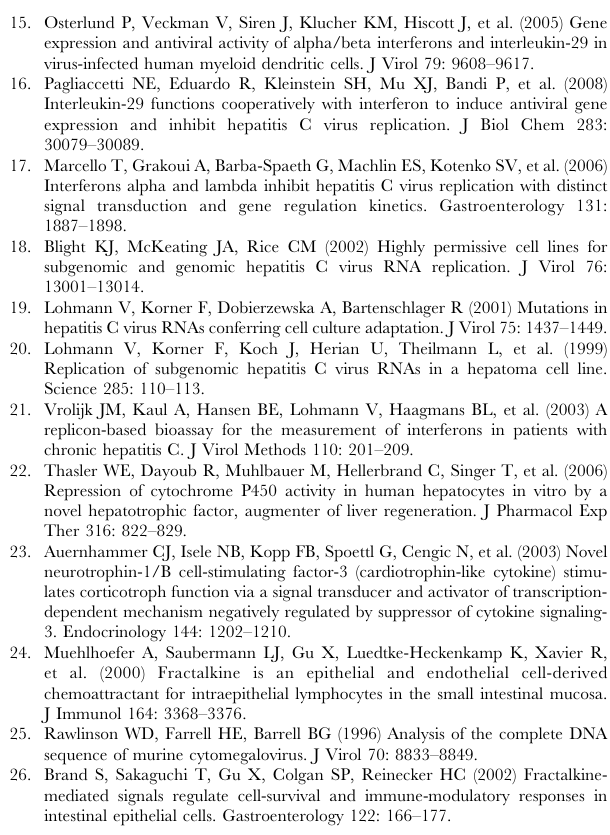
Figure S1 Functional categorization of IL-28A and IL-29 induced gene expression. In all classifications, p-values , 10 2 5 vs. the distribution of all genes on the microarray chip were considered as significant enrichment. Main classification groups are depicted in bold letters, while subgroups are written with normal letters. (A) Following IL-28A and IL-29 stimulation, genes of the biological processes of immunity and defense (with its subgroup interferon-mediated immunity) are significantly en- riched. Proteolysis gene expression is significantly enriched only by IL-28A. In the legend, the classes are listed in a clock-wise